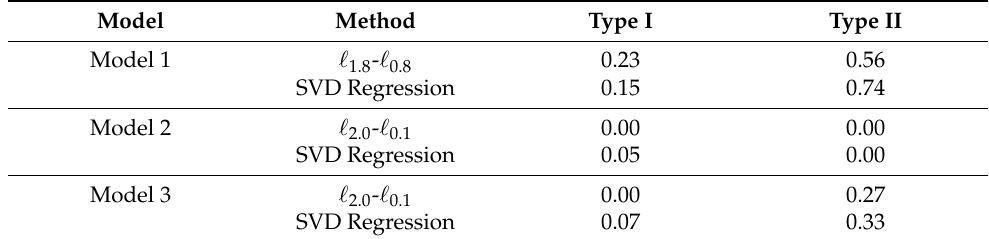
Table 6. Results for William’s Data (synthetic